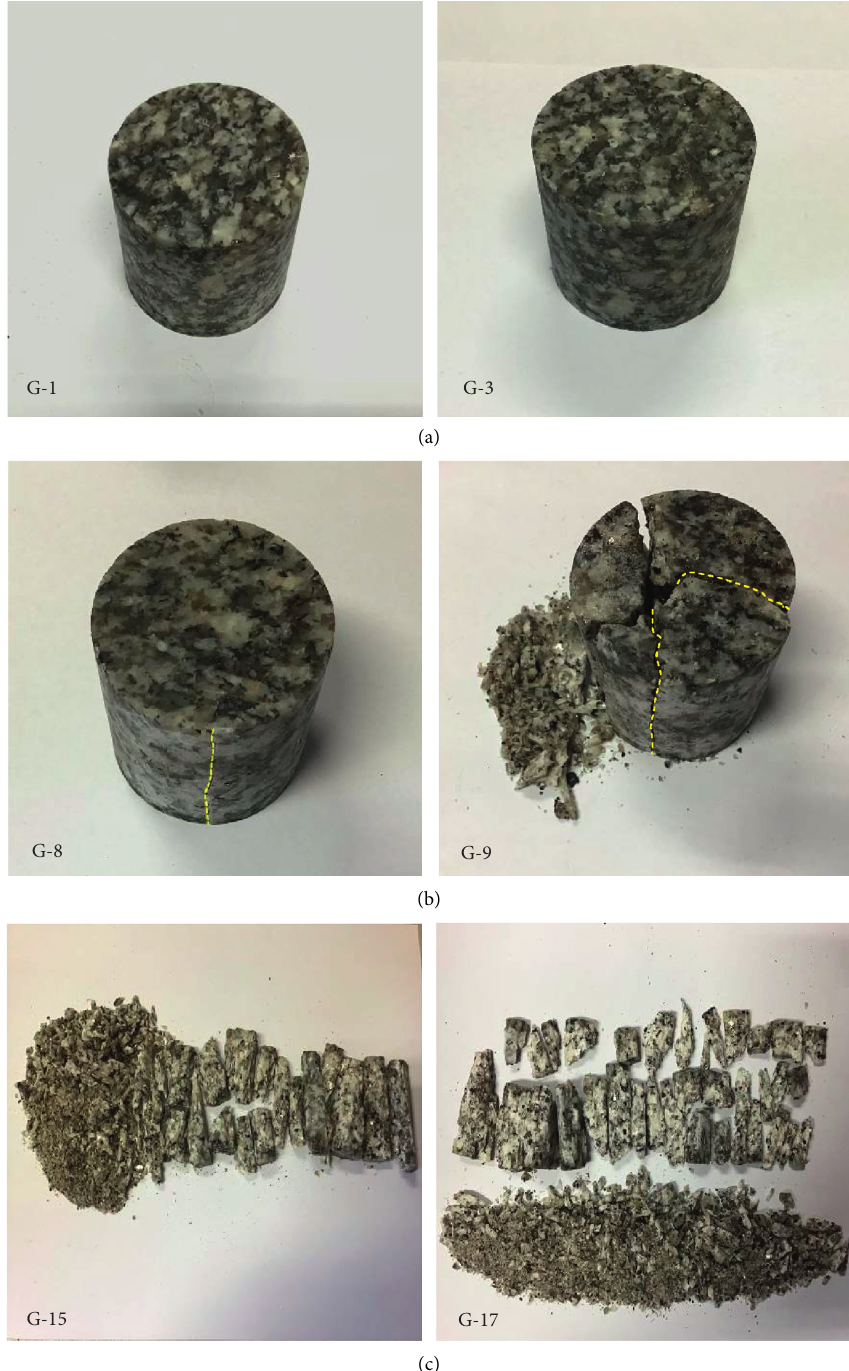
Figure 5: Granite specimens after impact tests. (a) Type I (unruptured state) specimens G-1 and G-3. (b) Type II (ruptured state) specimens G-8 and G-9. (c) Type III (fragmented state) specimens G-15 and